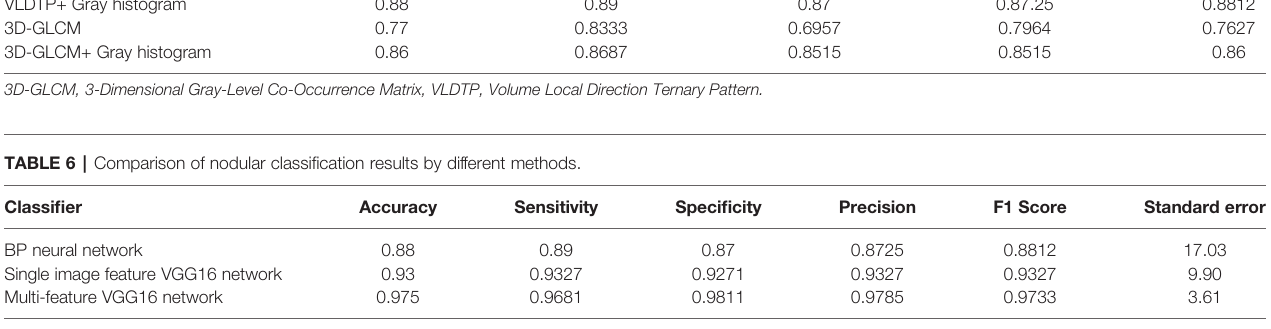
TABLE 5 | Comparison of the classi fi cation results of pulmonary nodules by BP neural network. Feature extraction method